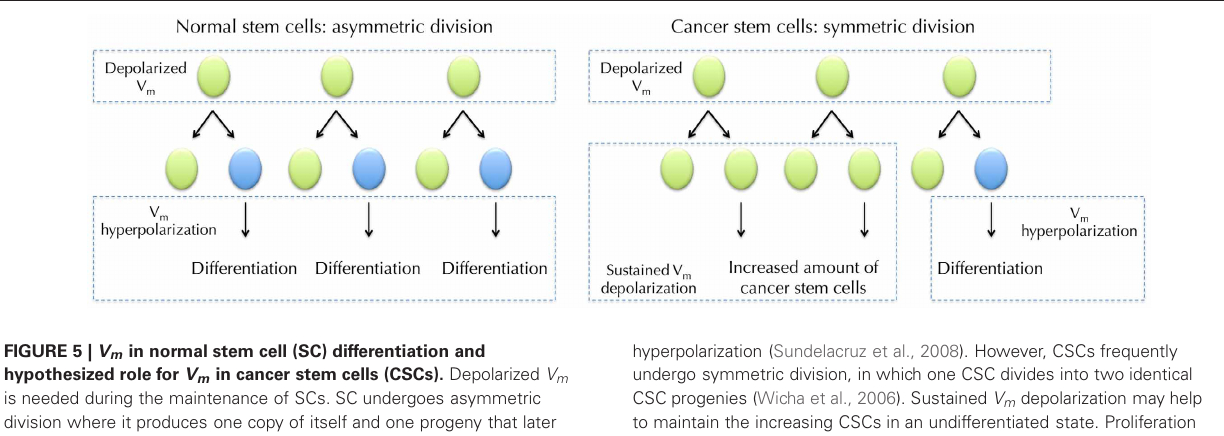
FIGURE 5 | V m in normal stem cell (SC) differentiation and hypothesized role for V m in cancer stem cells (CSCs). Depolarized V m is needed during the maintenance of SCs. SC undergoes asymmetric division where it produces one copy of itself and one progeny that later differentiate into mature cells. The maturation requires V m